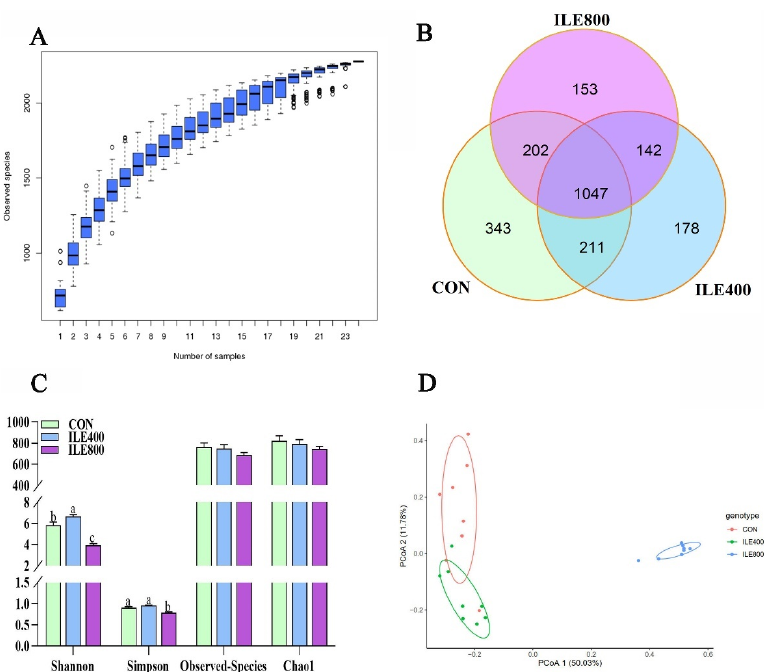
Figure 3. The effect of dietary supplementation with various levels of isoleucine (Ile) on the composition of cecal microbiota. ( A ) The species accumulation boxplot; ( B ) Venn diagram; ( C ) Alpha diversity indexes; ( D ) Principal Coordinate Analysis (PCoA) based on Bray–Curtis distance. CON, broiler chickens were fed the basal diet; ILE400, basal diet supplemented with 400 mg/kg Ile; ILE800, basal diet supplemented with 800 mg/kg Ile. The values are presented as the mean and standard error of mean (SEM), and statistically significant differences are those with a,b,c p < 0.05.